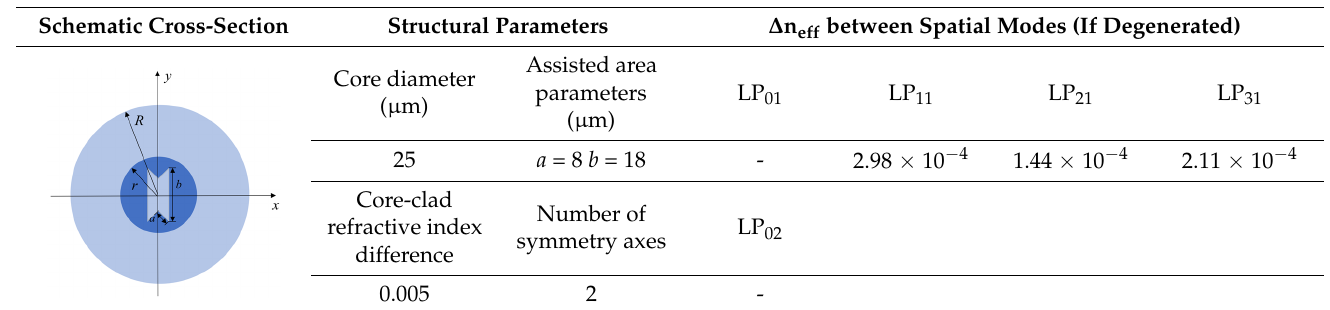
Table 4. Mode properties when the central-assisted area is a concave polygon (at the wavelength of 1550 nm). The Shape of the Central-Assisted Area: Concave Polygon